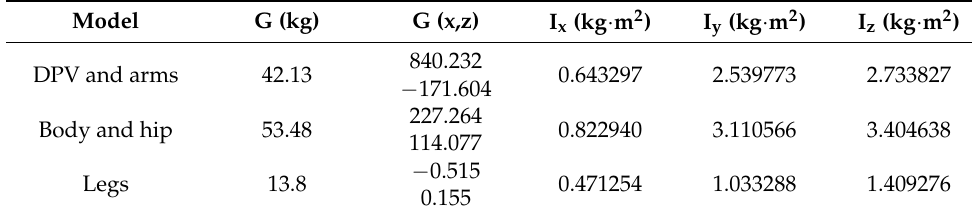
Figure 8. Simplified three 6-DOF rigid bodies. Table 4. Mass properties of three 6-DOF bodies